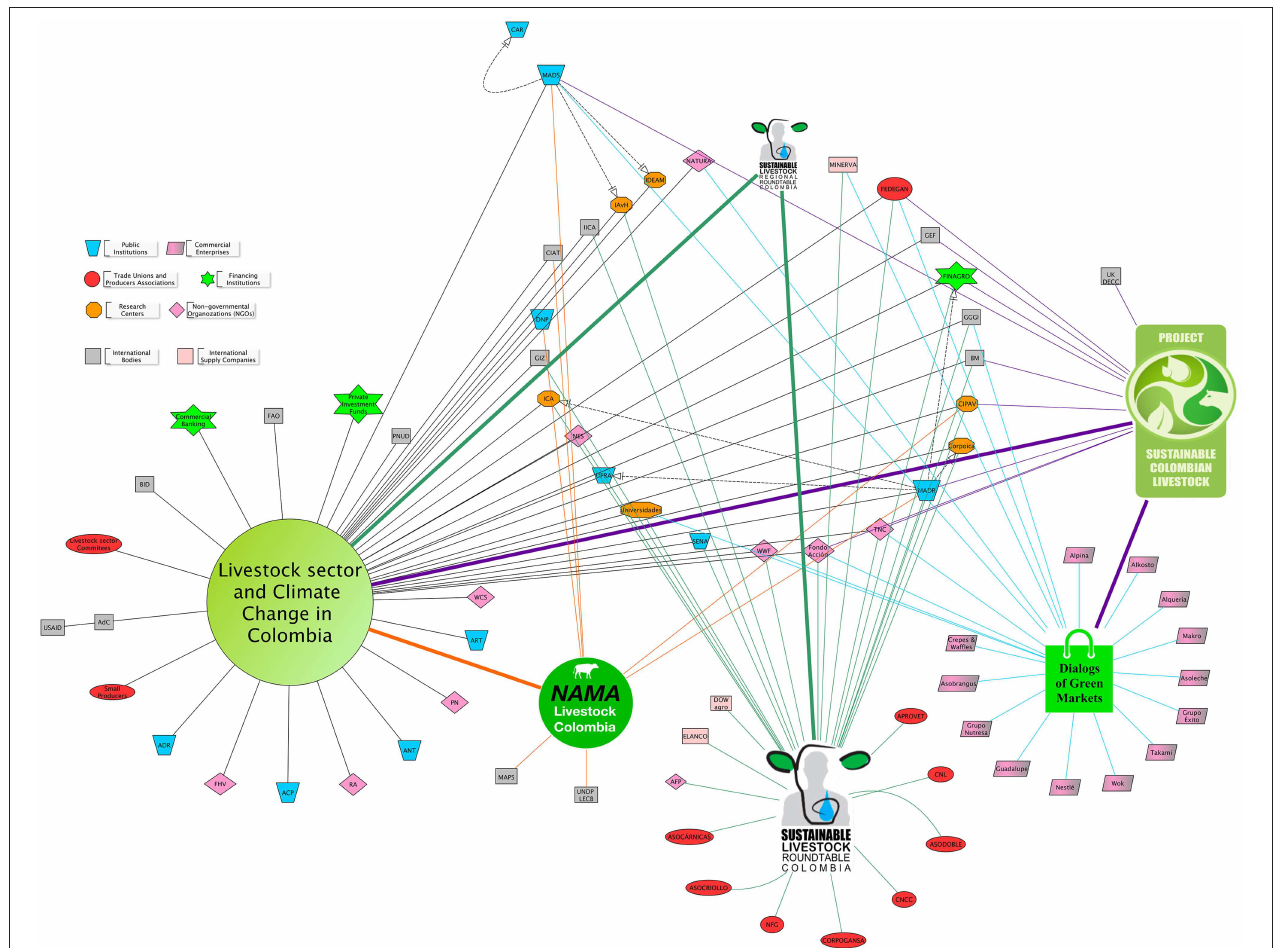
FIGURE 3 | Map of actors around the policies, plans and initiatives of climate change in the livestock sector in